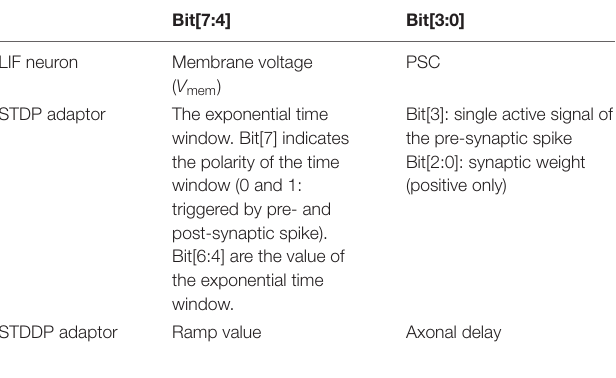
TABLE 1 | Arrangement of the neural states.